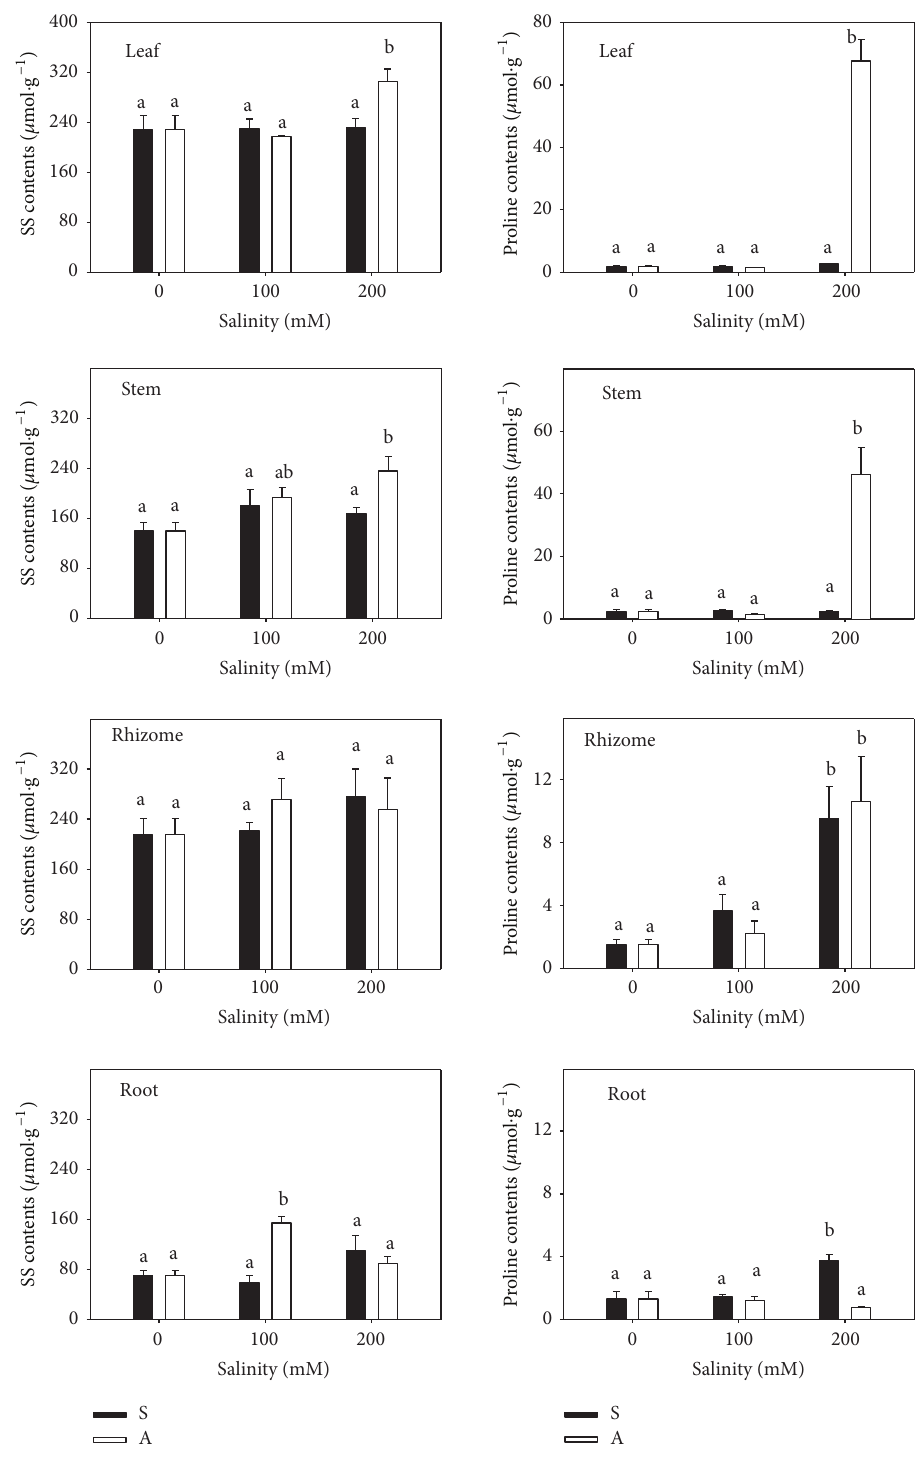
Figure 6: The SS and proline contents. The effects of salt stress (S) and alkali stress (A) on the SS and proline content in rhizomes, stems, roots, and leaves of L. chinensis . There are three levels under both stresses: 0, 100, and 200 mmol/L. The means and standard errors are reported. Within each column, the different letters indicate significant difference among treatments ( 𝑃 < 0.05